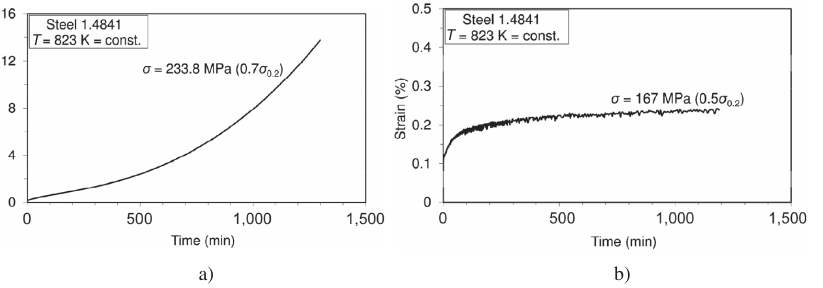
Figure 4: Creep behaviour of steel 1.4841 at a temperature of 823 K. (a) Stress level of 233.8 MPa and (b) stress level of 167 MPa.